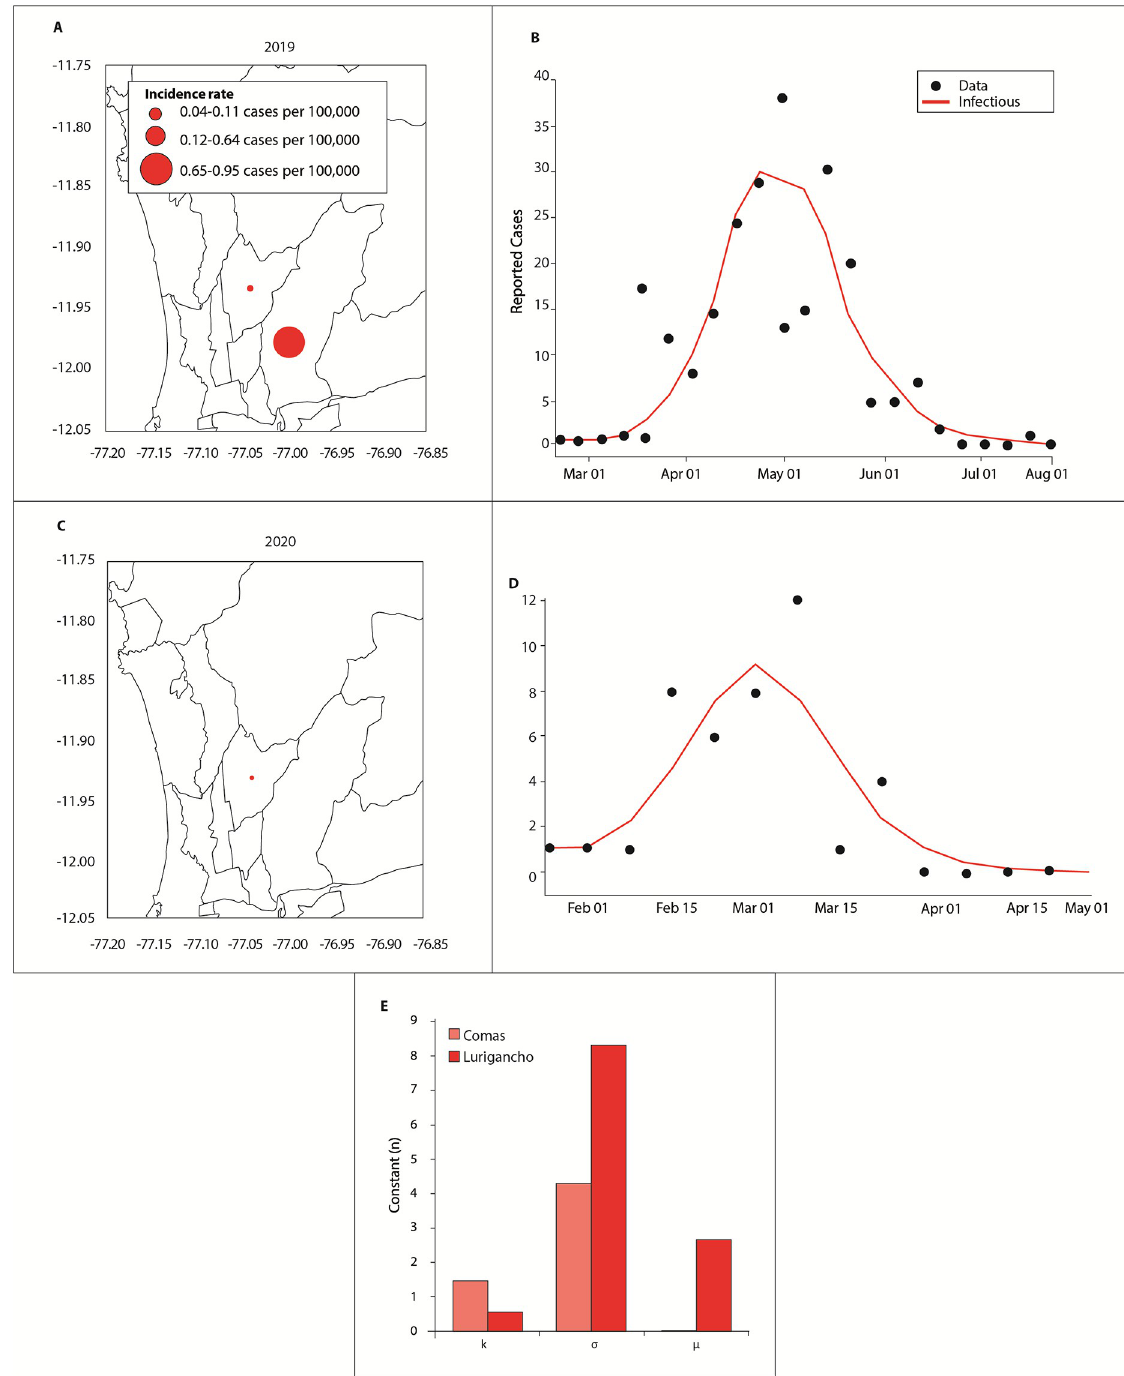
Fig 9. Dengue cases in 2019 for Lurigancho and Puente de Piedra. The black dots and red line correspond to the reported dengue cases and adjusted curve using model 4, respectively.